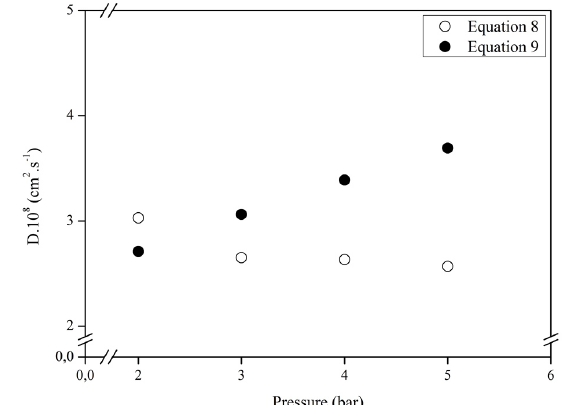
solubility coefficient in PSf membrane as a feed Figure 6 - CO 2 pressure functions at 35°C.